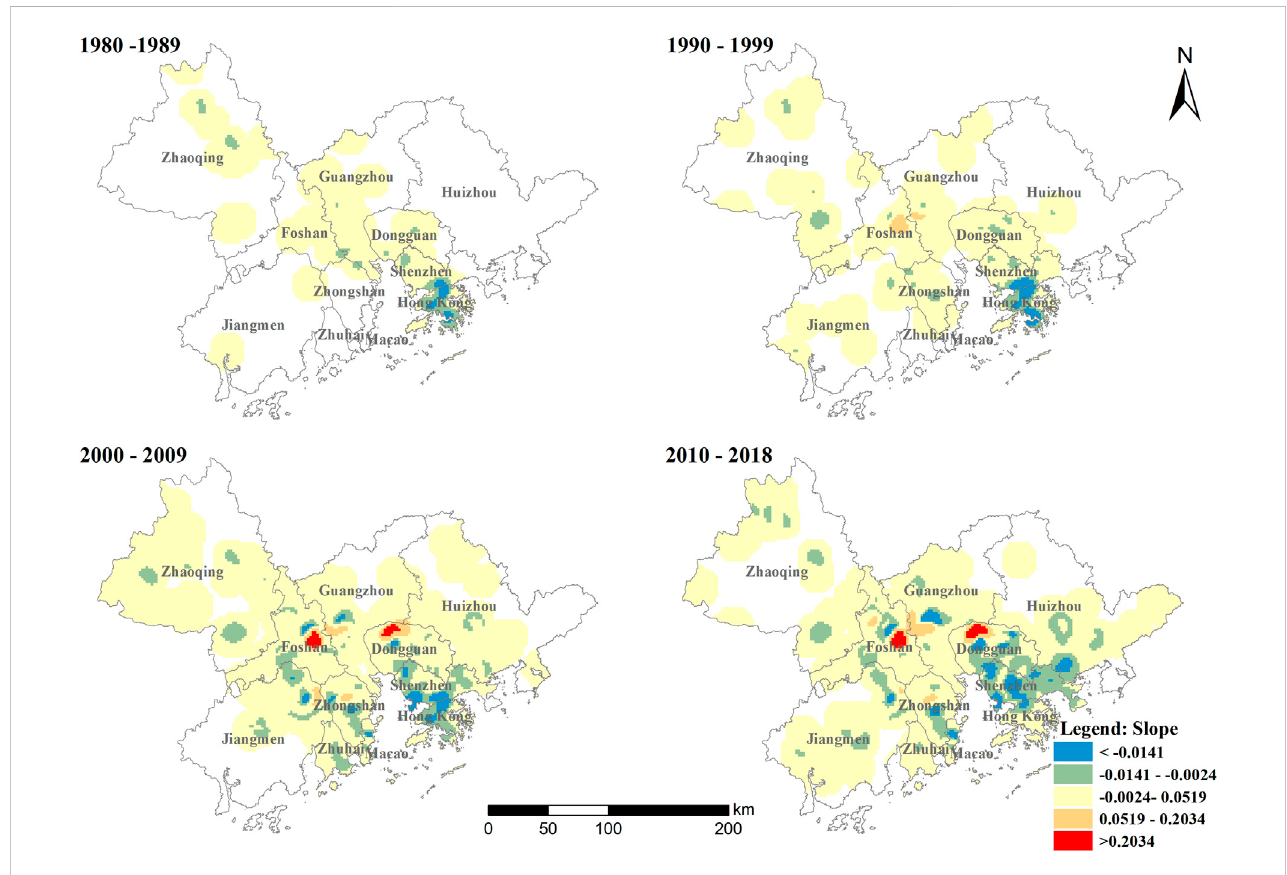
FIGURE 10 Spatial distribution of regression coef fi cients for Slope during 1980 –